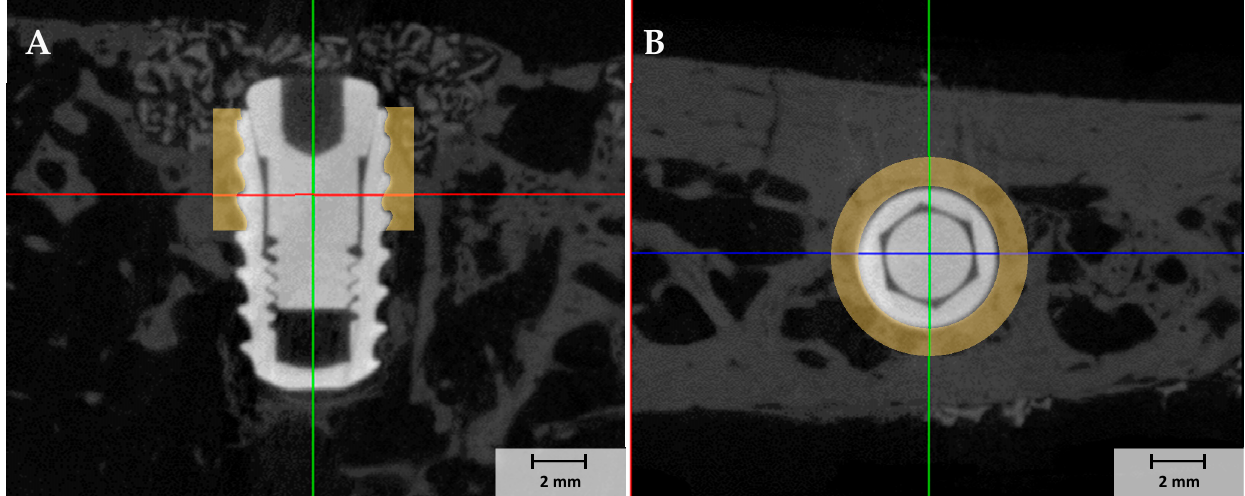
Figure 2. The µ CT images of regions of interest (ROIs) which included 1 mm around each implant. ( A ) buccal view, ( B ) occlusal view.